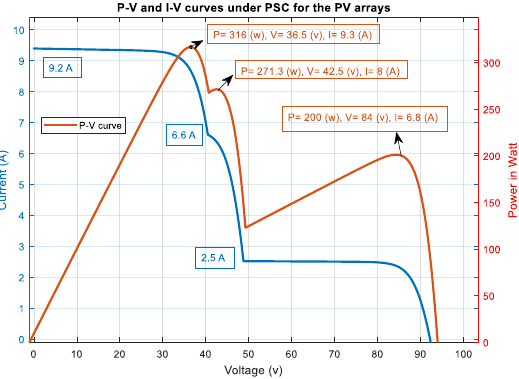
Figure 2. The P - V and I - V characteristics of the partially shaded PV arrays (Source: Authors).